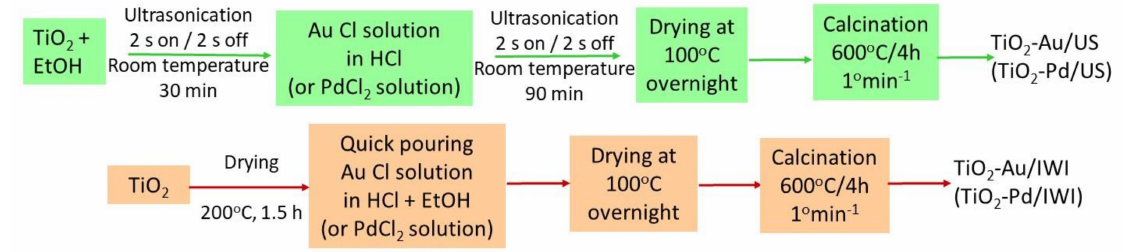
Figure 1. Flow chart of the main steps for the protocols used in this study for catalyst